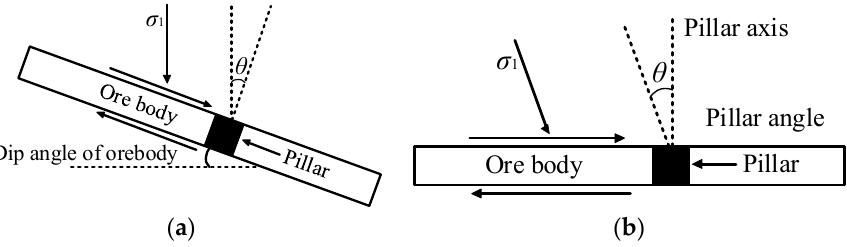
Figure 2. Pillar under combined compression and shear loading: ( a ) when the ore body is inclined, the maximum principal stress is vertical; ( b ) when the orebody is horizontal, the maximum principal stress is inclined.